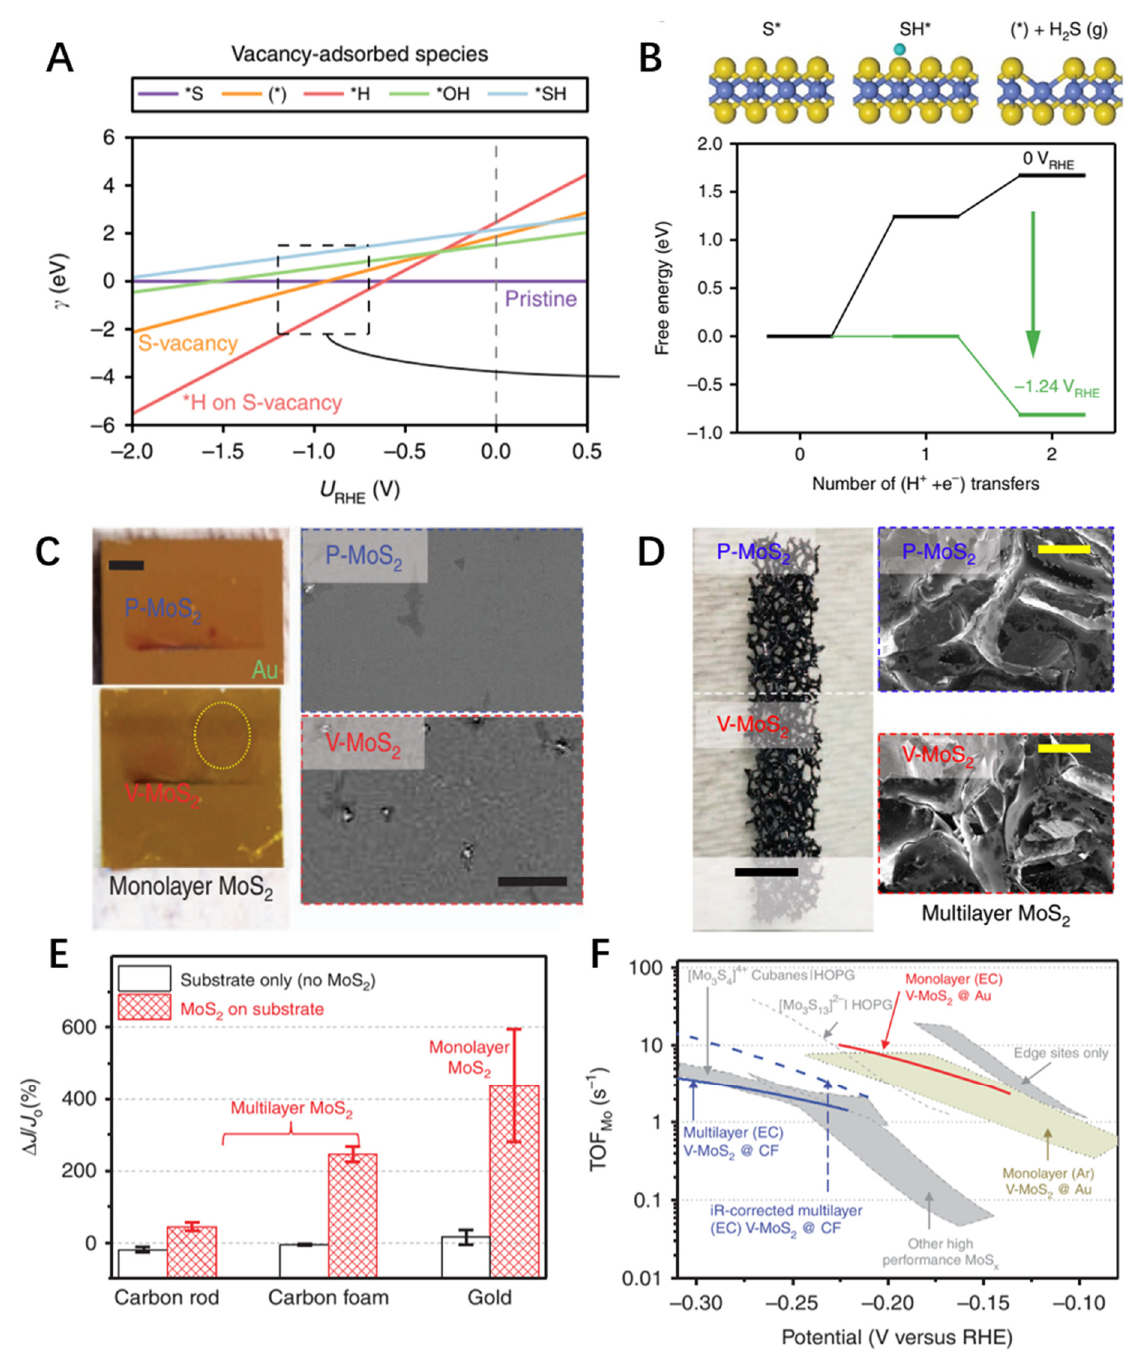
Figure 8. ( A ) The unit cell surface energy of 2H-MoS 2 at fixed sulfur vacancies as a function of the applied potential of 2H-MoS 2 substrates with different adsorbent species (3.1%). (*) refers to the S vacancy, and the adsorbed species in the S vacancy is indicated by the prefix *. For example, (*S) refers to the sulfur adsorbed in the vacancy, i.e., the original basal plane without the S vacancy. ( B ) A schematic diagram of the EC desulfurization process is shown at the top of the figure. The lower part shows the free energy diagram for the protonation and removal of S. The green line indicates the free energy path at the applied potential required to make all paths functional. ( C ) Optical and SEM images of monolayer MoS 2 before desulfurization (P-MoS 2 ) and after desulfurization (V-MoS 2 ). ( D ) Optical and SEM images of multilayer MoS 2 films before (P-MoS 2 ) and after (V-MoS 2 ) desulfu- rization. ( E ) Statistics regarding the desulfurization effect of multilayer molybdenum disulfide on carbon rods and carbon foam substrates and the desulfurization effect of monolayer molybdenum disulfide on gold substrates on improving HER activity. The rods without MoS 2 attachment show